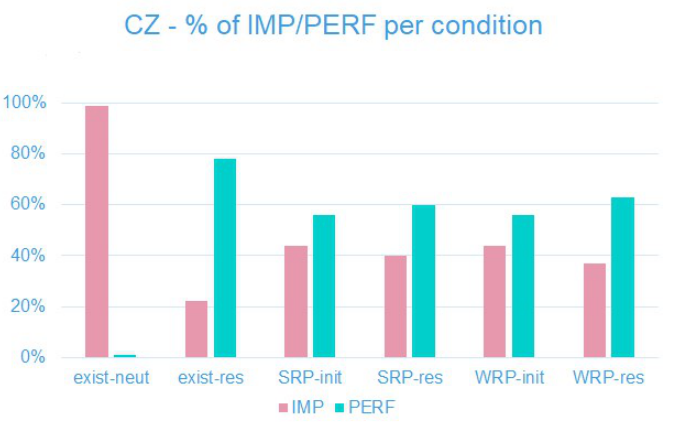
Figure 8. The percentage of perfective and imperfective aspect choices in Russian, Polish, and Czech in all the conditions.